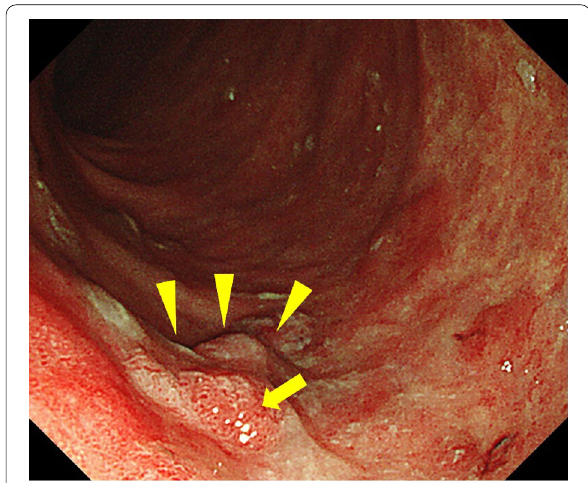
Fig. 2 Surveillance colonoscopy image showing an elevated lesion in the ascending colon (arrowheads). This lesion was diagnosed as well-differentiated adenocarcinoma based on the biopsy findings (arrow shows the biopsy